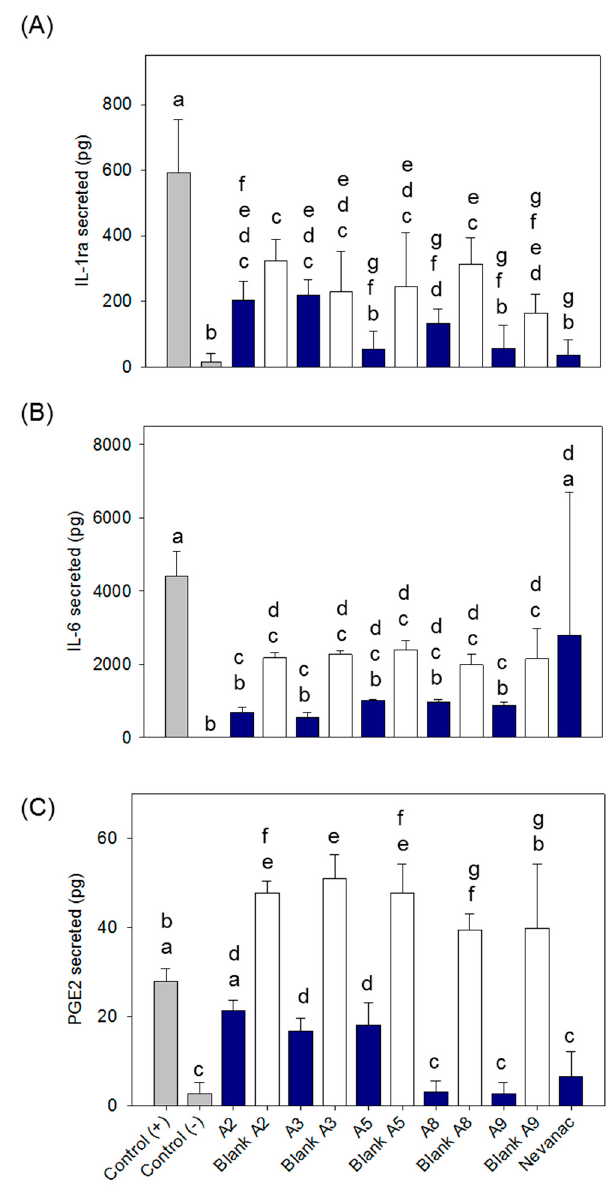
Figure 9. Effect of ophthalmic formulations on the secretion levels of ( A ) interleukin-1 receptor agonist (IL-1ra), ( B ) IL-6, and ( C ) prostaglandin E2 (PGE2) in macrophages. Negative controls refer to unstimulated cells (without lipopolysaccharide (LPS)); positive control refers to cells only stimulated with LPS. Same letters denote statistically homogeneous groups (ANOVA and multiple range test p < 0.05; n =